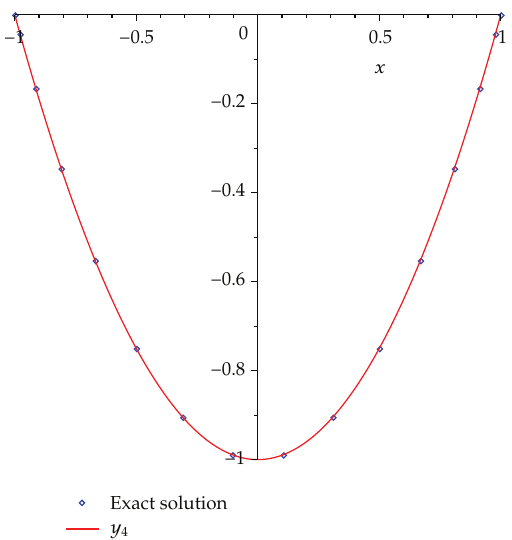
Figure 1: Comparison of the numerical solution with the 4th-order SHAM solution for h (cid:8) − 0 . 85.